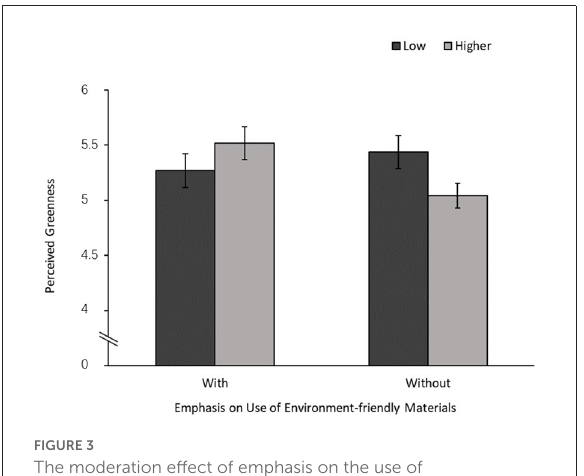
FIGURE3 The moderation effect of emphasis on the use of environment-friendly materials.